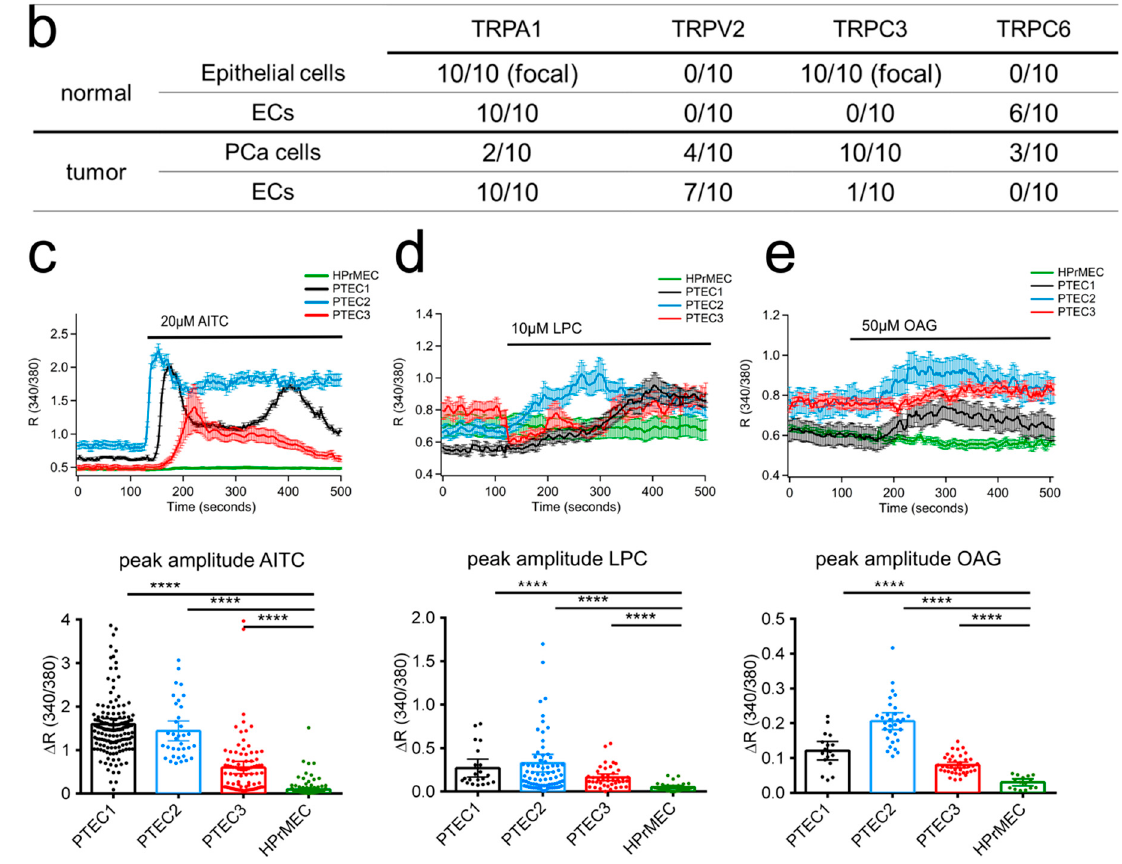
Figure 2. Protein expression of ‘ prostate-associated ’ genes in PTEC and HPrMEC. ( a ) (panel a i , ×20) TRPA1 expression in normal areas: focal positive staining in epithelial cells (red arrows) and diffuse staining in ECs (blue arrows). (panel a ii , ×20) In tumor areas, TRPA1 expression is observed in all cases ( n = 10/10) in ECs (blue arrows), with negative staining in tumor cells (red arrows). (panel b i , ×40) In histologically normal areas, TRPV2 expression is not observed in ECs ( n = 0/10) (blue arrows) or epithelial cells (red arrows). (panel b ii , ×40) Positive endothelial TRPV2 expression was observed in 7 of 10 cases in the tumor areas (blue arrows), with positive staining in cancer cells in 4 cases (red arrow). TRPC3 expression: (panel c i , ×40) all normal tissues showed negative staining ( n = 10/10) in ECs (blue arrows) with focal positive staining in epithelial cells (red arrow). (panel c ii , ×10) Only one tumor ( n = 1/10) showed faint positive TRPC3 staining on ECs (blue arrow), whereas cancer cells were positive (red arrows) in all cases. (panel d i , ×20) TRPC6 expression was observed in ECs in histologically normal tissues ( n = 6/10), (panel d ii , ×40) whereas TRPC6 expression was absent in cancer cells in 7 out of 10 patient samples (red arrows). ( b ) Summary of endothelial and epithelial expression of the four ‘ prostate-associated ’ candidates in both normal and tumor areas for the ten patient samples used for immunohistochemical analysis. The patients were 62 to 70 years old, with PCa classified as ISUP group 2 in six cases and group 3 in four cases. Ca 2+ - imaging traces in response to TRPA1, TRPV2 and TRPC3 agonists respectively ( c ) 20 µM AITC), ( d ) 10 µM LPC and ( e ) 50 µM OAG in PTEC1 (black), PTEC2 (blue) and PTEC3 (red) but not in HPrMEC (green).Traces represents mean ± SEM of cells in the recorded field of one representative experiment. Lower panel: histogram showing peak amplitude of TRP agonist-mediated Ca 2+ responses (mean ± 95% CI of different cells in the field from at least 3 independent experiments). Statistical significance and ****: p -value < 0.0001 (Kruskal-Wallis test).